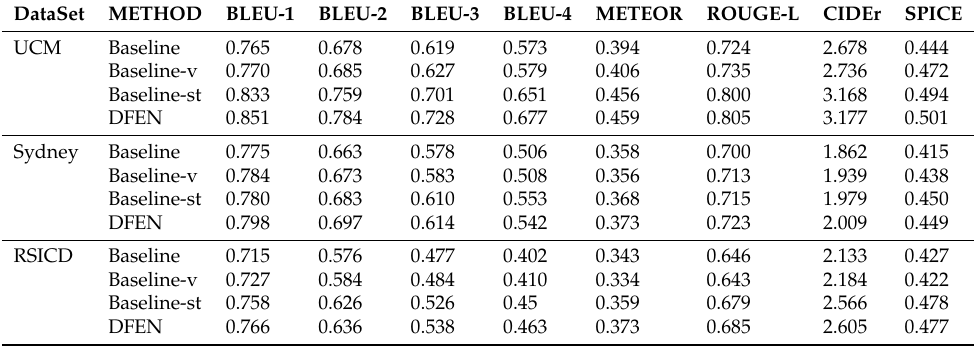
Table 4. Results of ablation experiment based on different remote sensing image caption